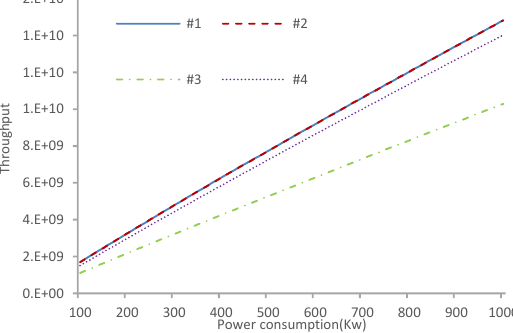
Figure 7. Throughput of different data centers.